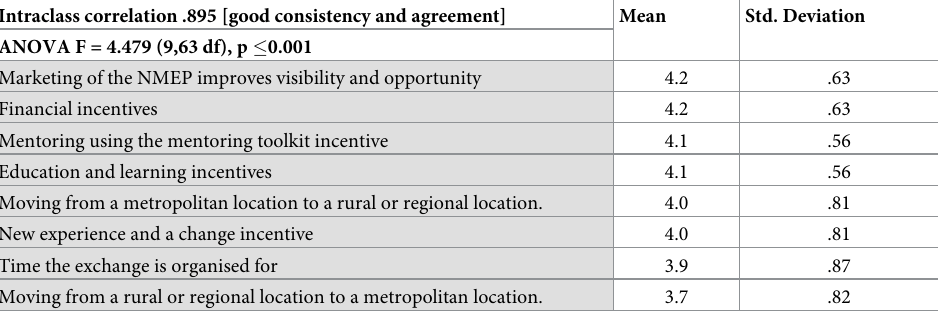
Intraclass correlation .895 [good consistency and agreement] Mean Std. Deviation ANOVA F = 4.479 (9,63 df), p � 0.001